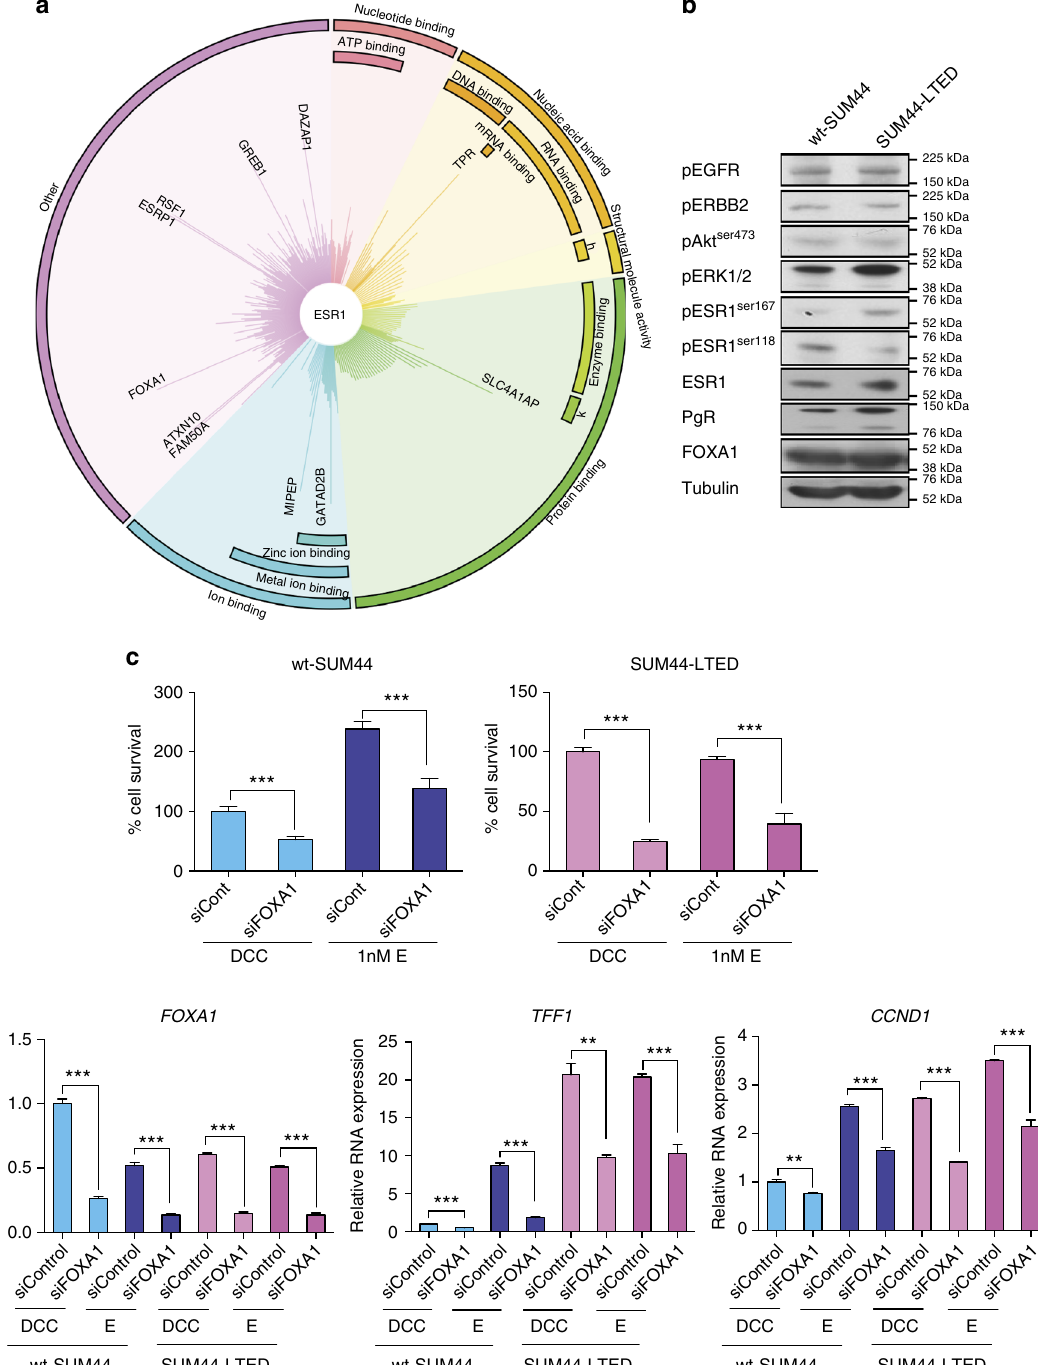
Fig. 3 Identi fi cation and functional analysis of the ESR1 Y537S interactome. a MS-ARC depicting ESR1-RIME data conducted on SUM44-LTED (ESR1 Y537S ) vs. wt-SUM44 (ESR1 wt ) ( n = 3 biological replicates). The ranking is based on SUM44-LTED/wt-SUM44 peptide (razor and unique) counts. The length of the line represents the number of identi fi ed peptides. The longer the line, the greater the interaction with ESR1 Y537S compared to ESR1 wt . The shorter cloud of lines shows the high degree of commonality in ESR1 binding proteins between both cell lines. b Immunoblotting showing alterations in expression of key protein markers previously associated with endocrine-resistant phenotypes. c Proliferation assays following siFOXA1 in wt-SUM44 and SUM44-LTED relative to siControl in the presence and absence of E (estradiol) ( n = 2 biological experiments with eight technical replicates). d Expression of estrogen- regulated genes, TFF1 , and CCND1 following suppression of FOXA1 ( n = 3 technical replicates). (error bars represent mean ± SEM, * p < 0.05, ** p < 0.01, *** p < 0.001, signi fi cance was assessed by Student ’ s t